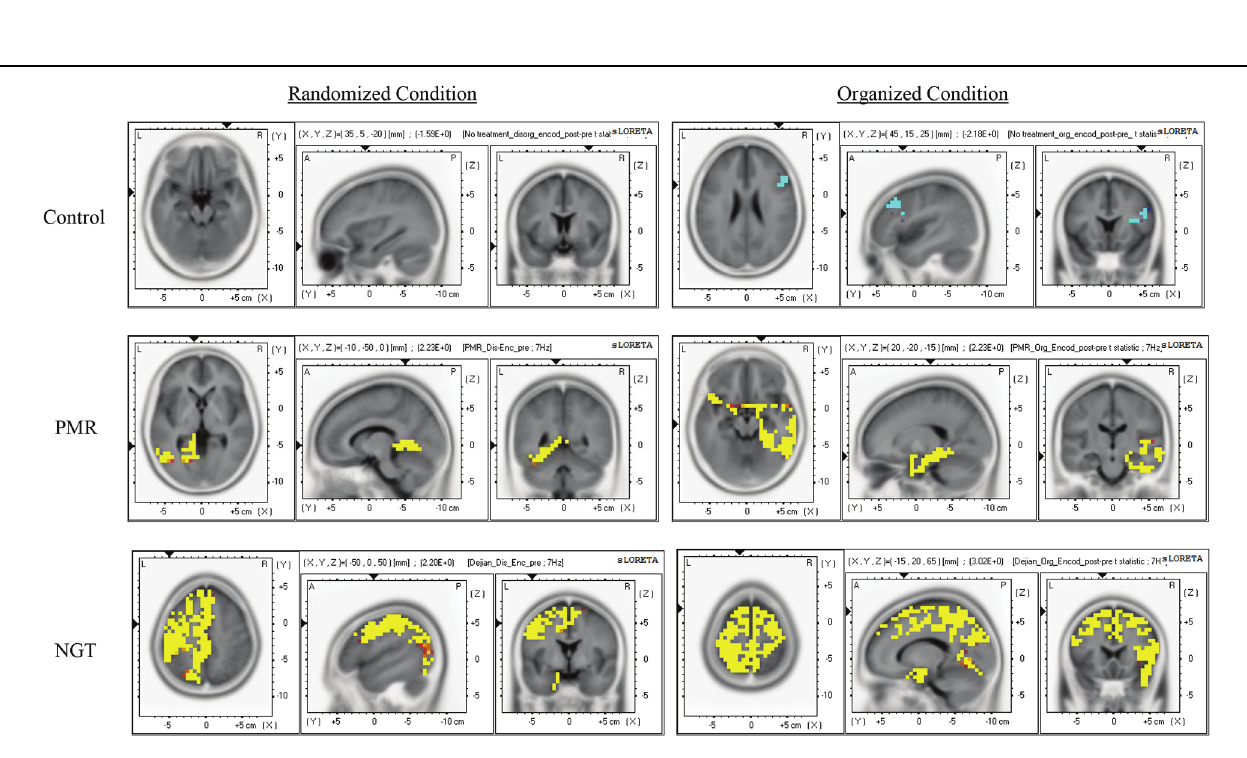
Frontiers in Psychology | www.frontiersin.org